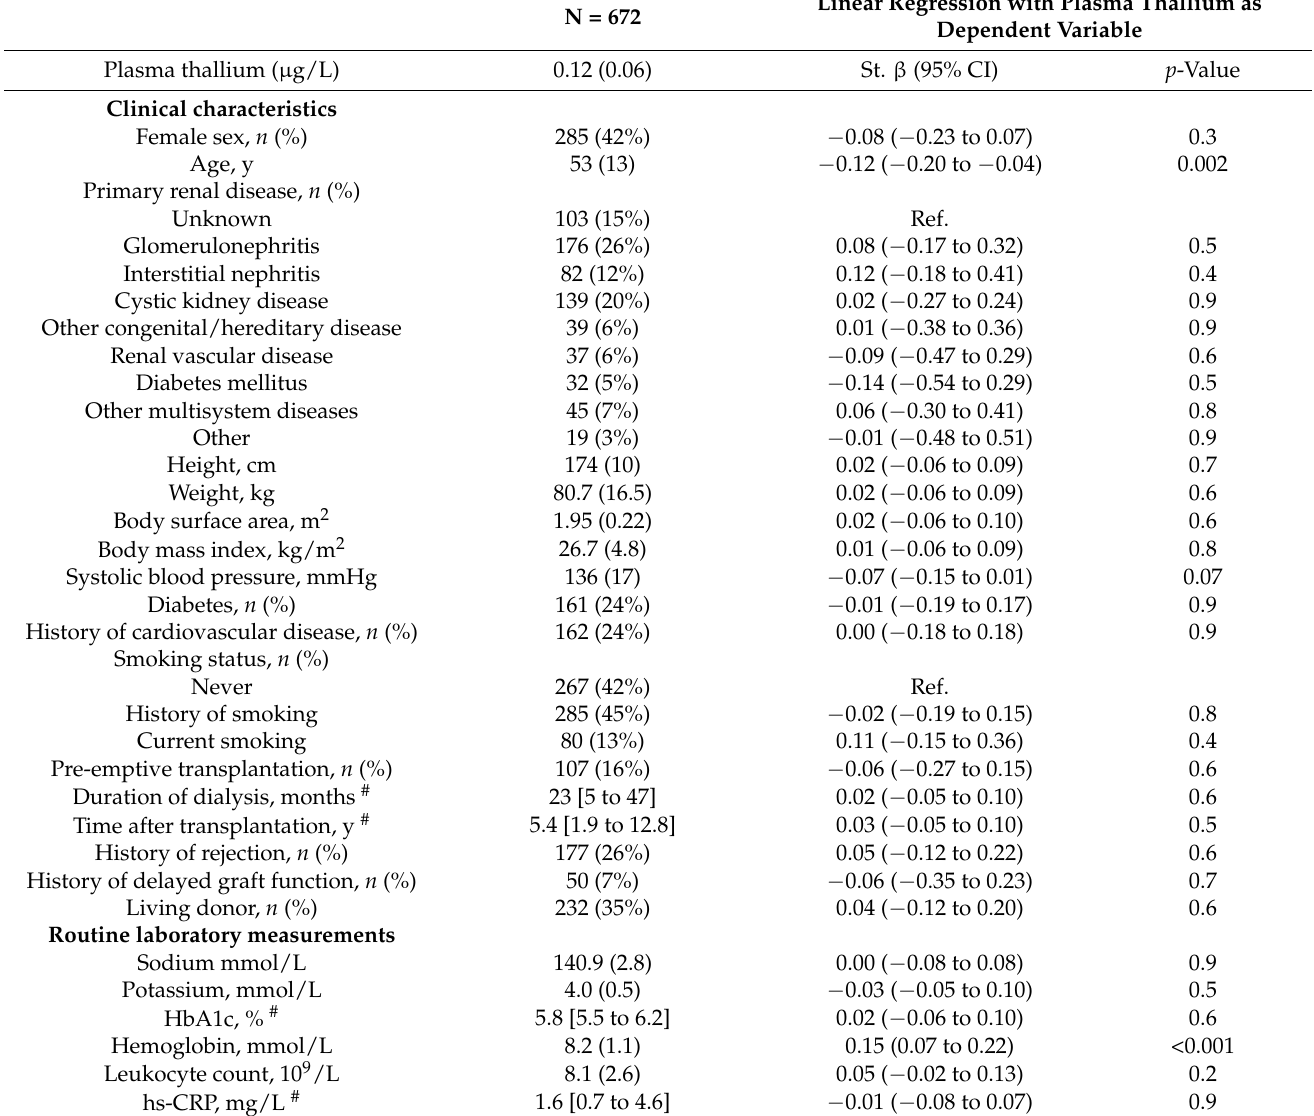
Table 1. Population characteristics at baseline and linear regression analyses for plasma thallium concentration. Linear Regression with Plasma Thallium as N = 672 Dependent Variable 0.12 (0.06) St. β (95% CI) p